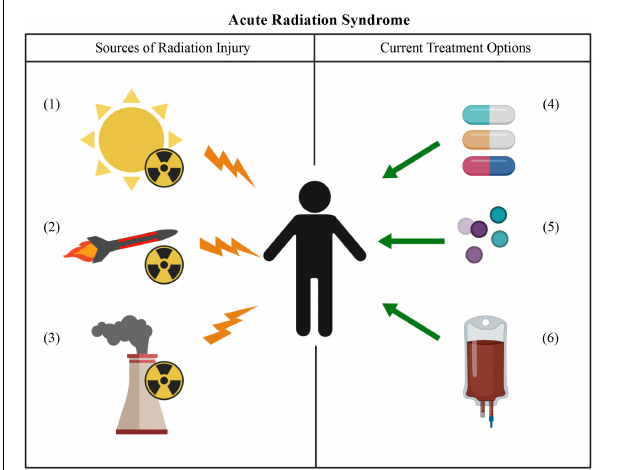
FIGURE 2 | Acute radiation syndrome: sources of injury and current treatment options. Sources of radiation injury can include solar flares (1), nuclear weapons (2), or an accident at a nuclear power plant (3). The current treatment options for ARS involve the use of antibiotics (4) and the growth factors G-CSF and GM-CSF (5). In the more severe cases of ARS, an HSCT may need to be performed (6).